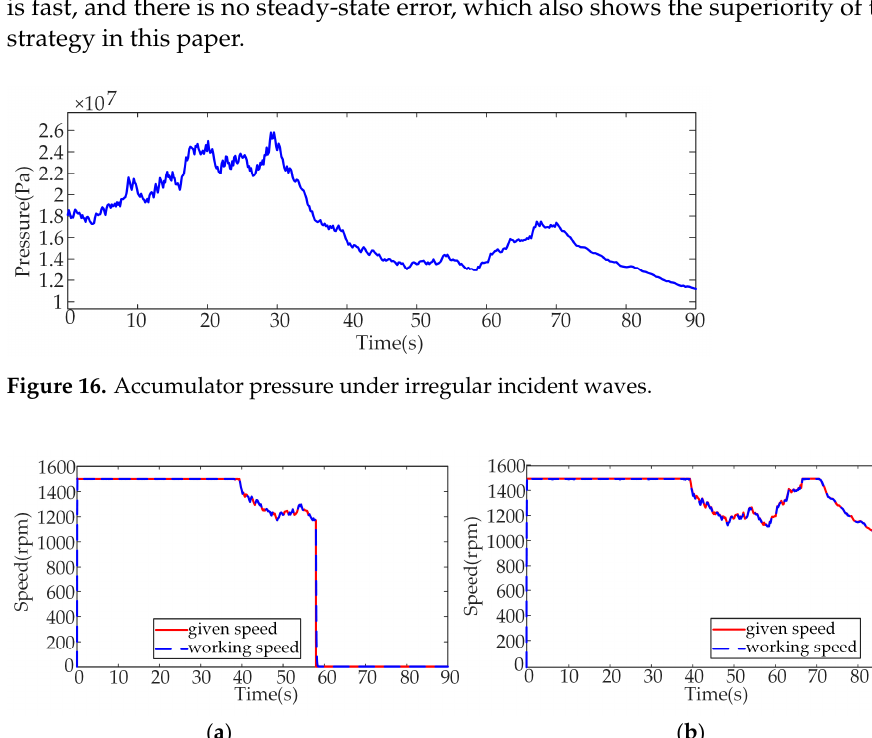
Figure 15. Irregular incident waves.